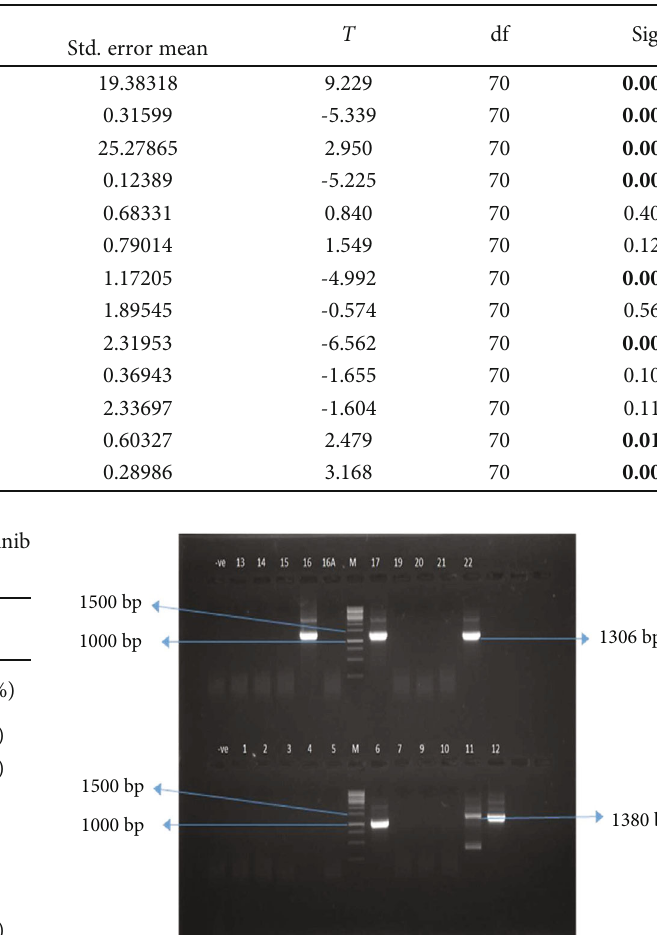
Table 5: Hematological parameter analysis by paired t -test of CML patients for monitoring before and after treatment of 12 months against imatinib mesylate.